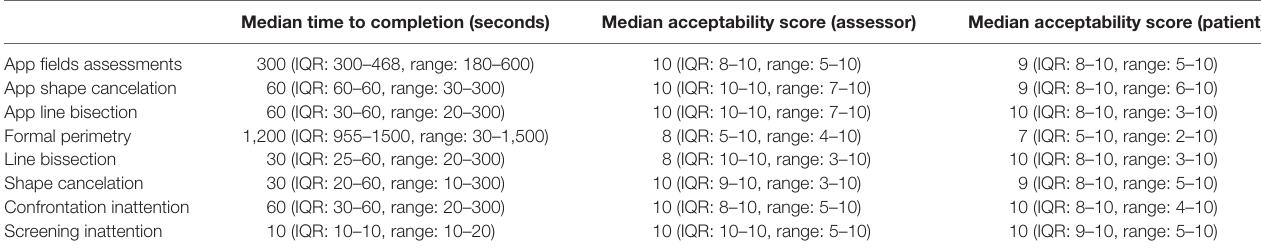
TaBlE 3 | Feasibility and acceptability of the Stroke Vision app. Median time to completion (seconds) Median acceptability score (assessor) Median acceptability score